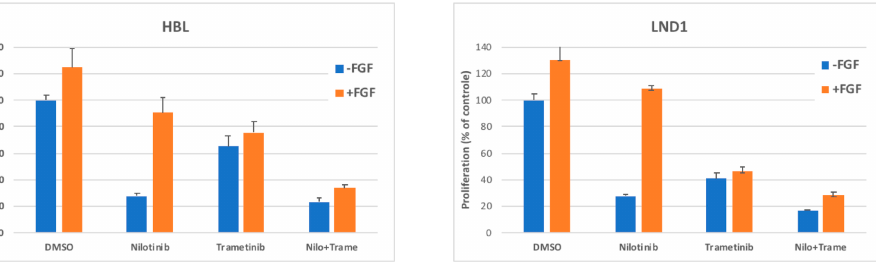
Figure 4. E ff ects of FGF2 MAPK pathway. ( A ) Cells were treated for 24 h with DMSO, 1 µ M nilotinib or 0.2 µ M Trametinib in the absence or in the presence of 20 ng / mL FGF2 and the levels of phosphorylated proteins or total proteins were analyzed by Western blotting. ( B ) Cells were treated with DMSO, 1 µ M nilotinib, 0.2 µ M trametinib or the combination of both in the absence or in the presence of 20 ng / mL FGF2 and proliferation was analyzed after 3 days (data are represented as mean +/ − SD). The combination of nilotinib and trametinib significantly reduced proliferation in all three cell lines in the presence of FGF2 (M230, p < 0.0005; HBL, p < 0.01; LND1, p < 0.002; unpaired t -test).